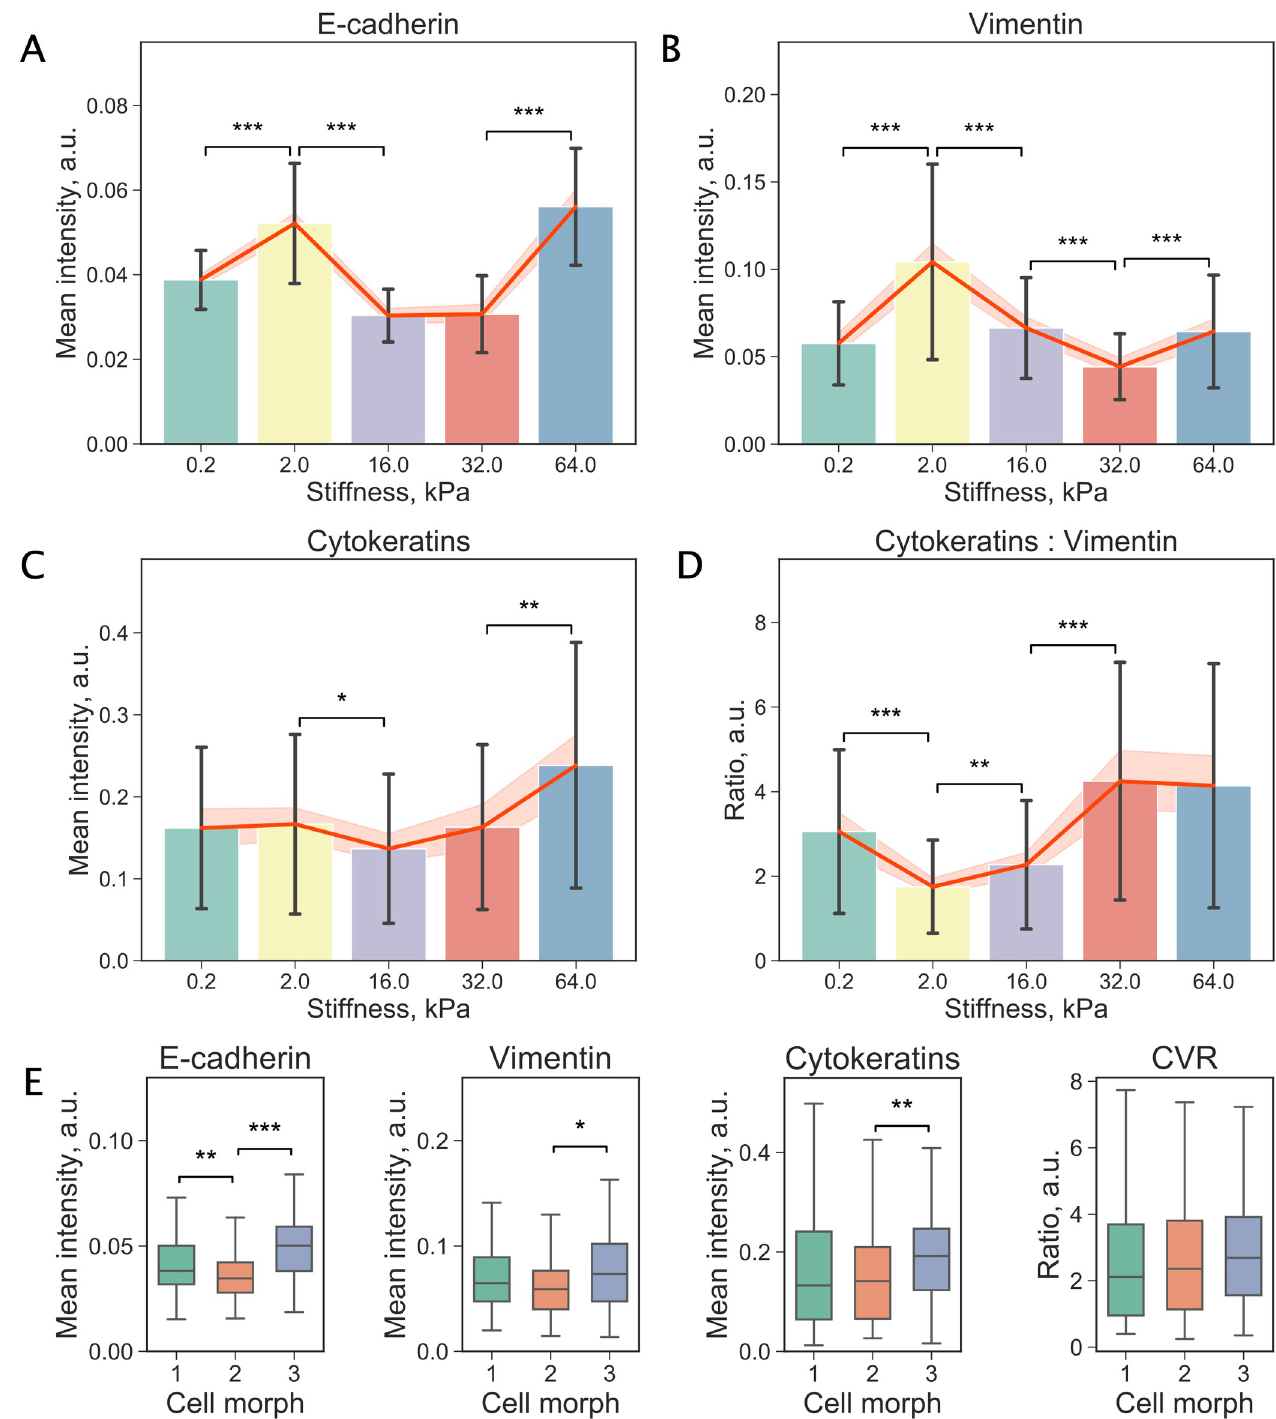
Fig 6. Changes in expression of biomarkers associated with epithelial and mesenchymal phenotypes. (a-c) Mean fluorescent signal from E-cadherin, vimentin, and cytokeratins, respectively, across substrates of different stiffness. (d) The ratio of fluorescence intensity of cytokeratins to vimentin (CVR) calculated for all stiffness values. For (a-d) values are mean, error bars indicate standard deviation. Orange line shows the mean values and the band indicates 95% confidence intervals. Significance of the difference assessed by Welch’s t-test (‘ ��� ’: p < 0.001, ‘ �� ’: p < 0.01, ‘ � ’: p < 0.05), n = number of cells, see Table A in S2 Text. (e) Box plots comparing mean fluorescent signal from E-cadherin, cytokeratins, and vimentin in cells belonging to three cell morphs. There appears to be no difference in CVR between the three cell morphs as can be seen in the rightmost plot. Distributions of the values are reported using box plots: a